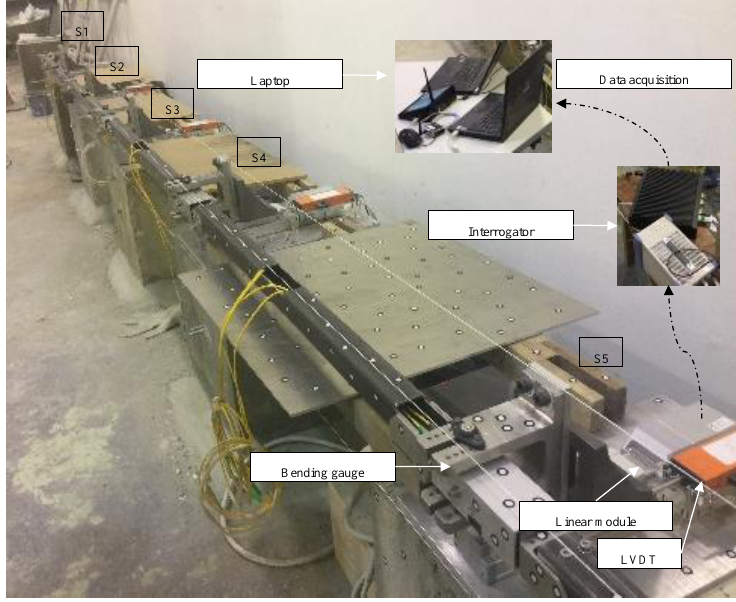
Figure 6. Laboratory test platform.